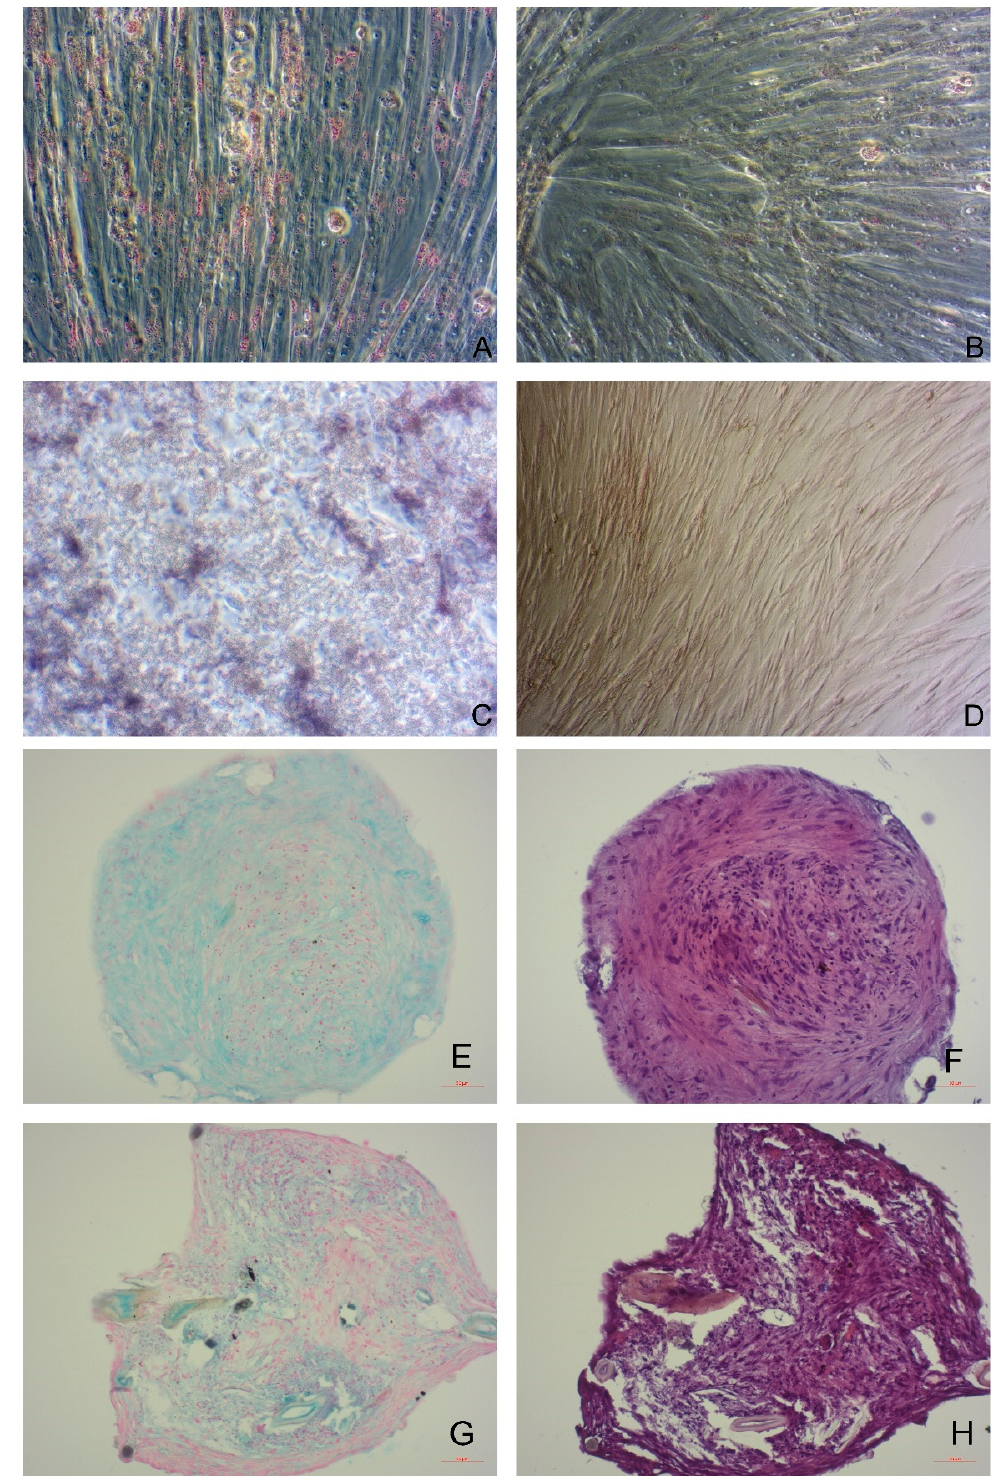
Figure 4. ( A , B ) Successful differentiation of canine adipose-derived mesenchymal stem cells (ASCs) in adipocyte differentiation media. When stained with Oil O Red, accumulated lipid droplets show high-intensity red staining within the cell ( A ) regarding control cultivated in basal medium ( B ). ( C , D ) Canine ASCs after successful osteodifferentiation; cells were stained with substrate to detect alkaline phosphatase activity. Purple strains of canine ASCs showed activity of alkaline phosphatase ( C ), while cells cultivated in basal medium (negative control) ( D ), showing low-intensity staining. 4E-H Images of histological sections of paraffin-embedded spheroids (20×, Zeiss, Germany) of canine ASCs three-dimensional culture after successful chondrodifferentiation. ASCs spheroids